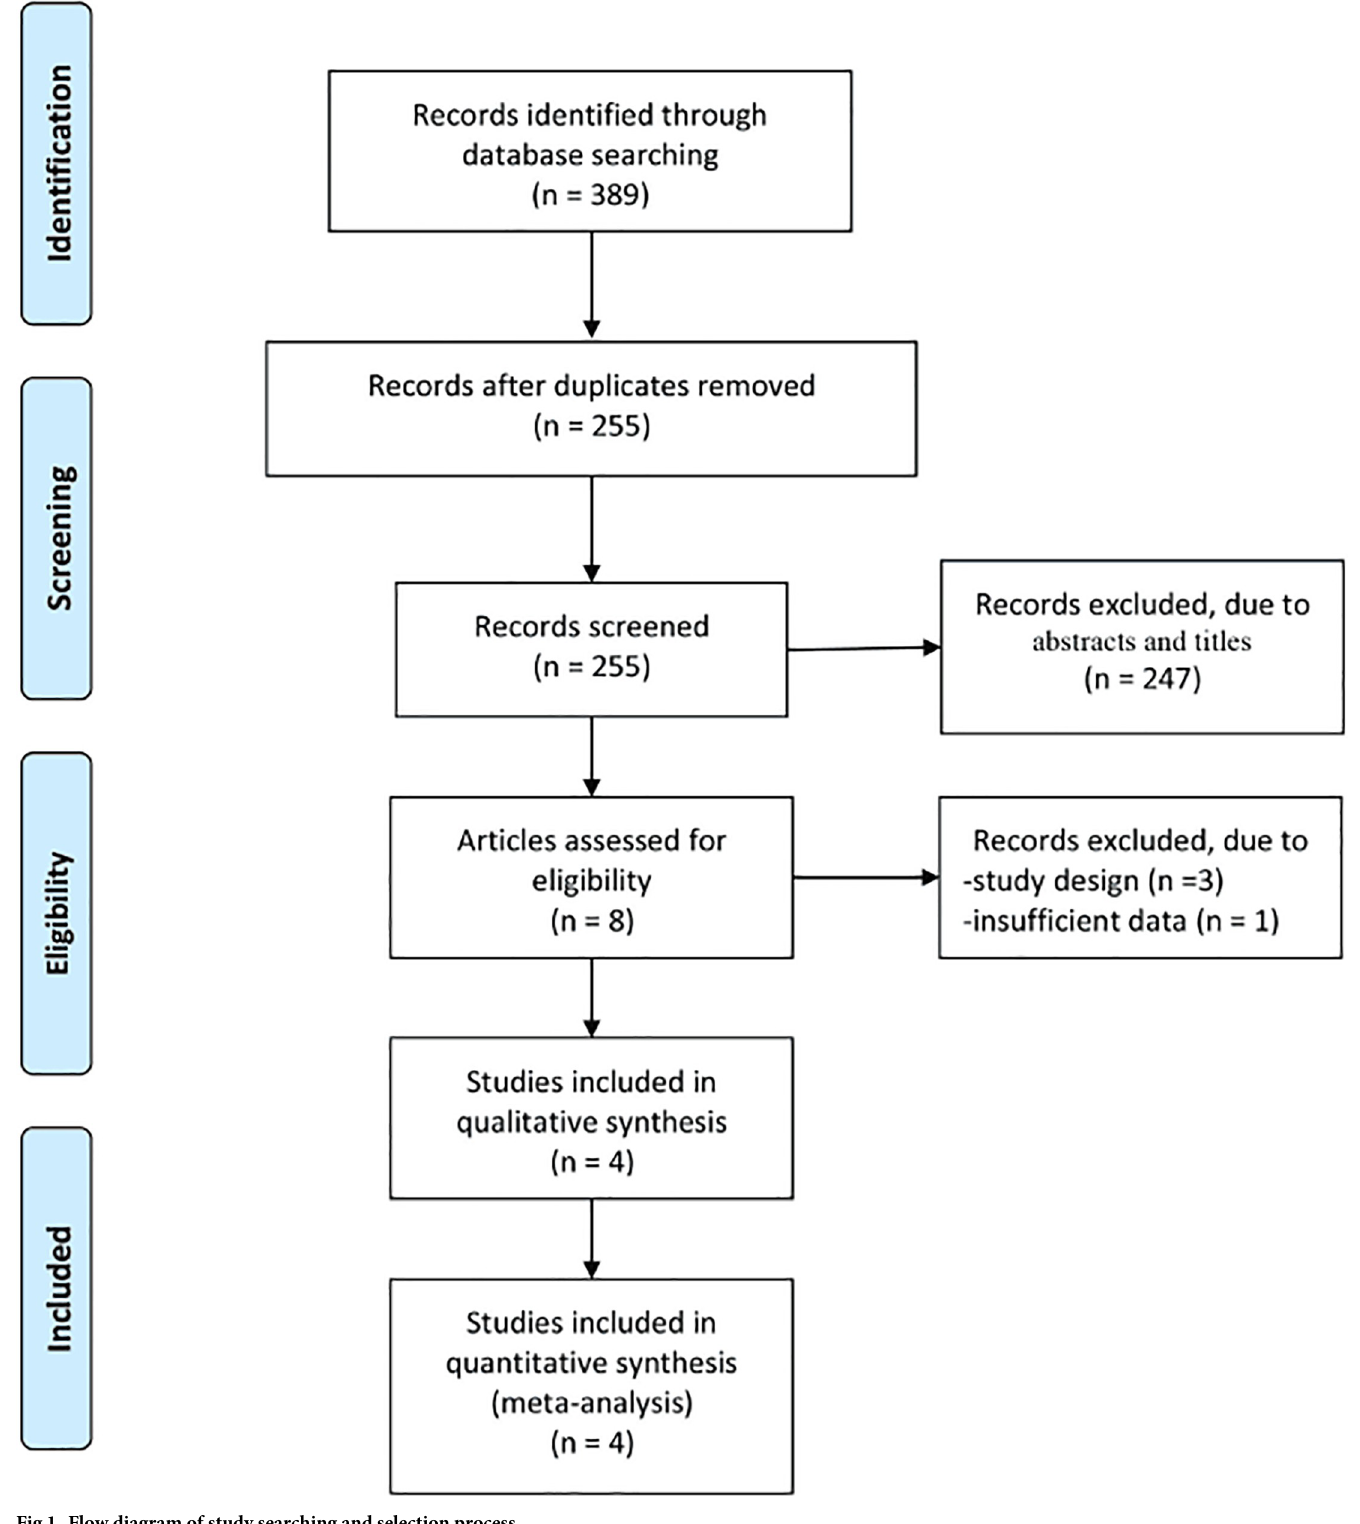
Fig 1. Flow diagram of study searching and selection process.